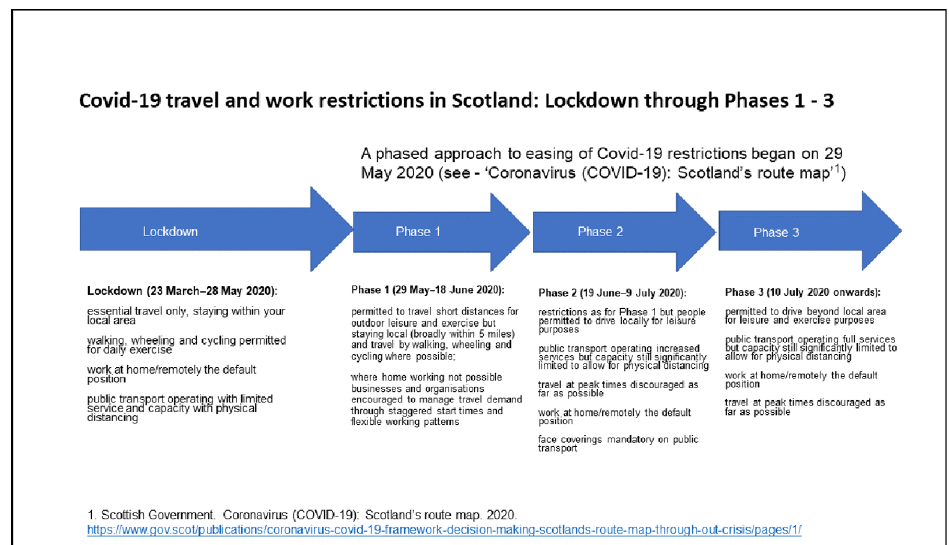
Figure 2: Details of COVID-19 travel and work restrictions in Scotland: lockdown through Phases